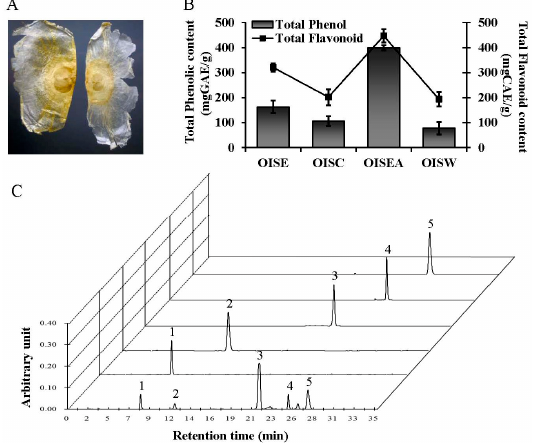
Figure 1. Characteristics of Oroxylum indicum seed. ( A ) A classical feature of Oroxylum indicum seed. ( B ) Total phenolic and flavonoid contents are shown. ( C ) A representative high-performance liquid chromatography (HPLC) profile of Oroxylum indicum seed extract with standards monitored at 280 nm. Gallic acid (Peak 1), caffeic acid (Peak 2), baicalein (Peak 3), chrysin (Peak 4), and oroxylin B (Peak 5) are also presented. OISE: ethanol extract; OISC: chloroform fraction; OISEA: ethyl acetate fraction; and OISW: aqueous fractions of Oroxylum indicum seed.